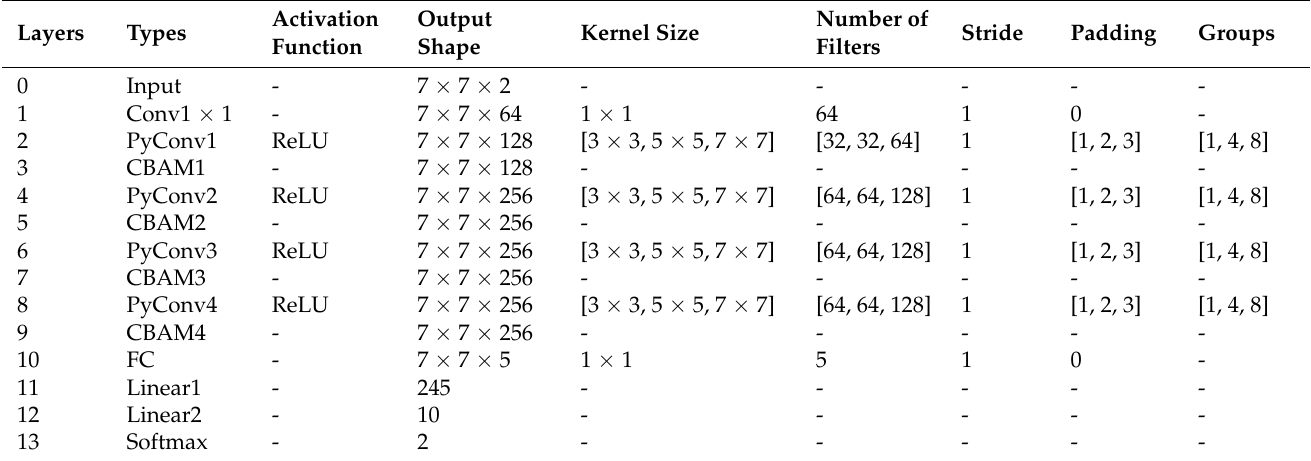
Table 1. The parameters of every layer in